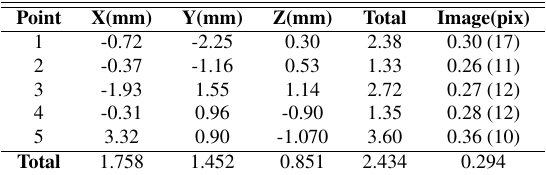
Table 6. GCPs RMSE - Flight 3 - 4/1/2020 12:01PM